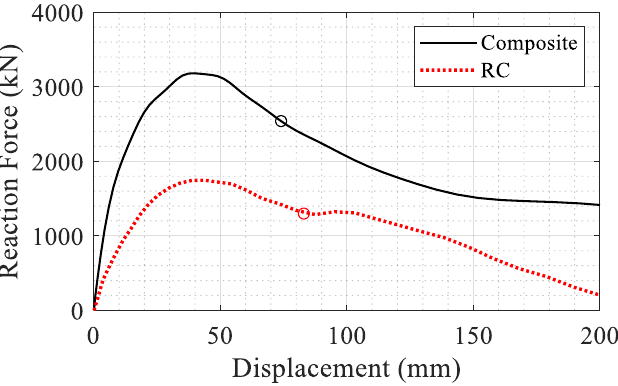
Figure 29. Comparison of residual axial capacity after blast damage between the two systems.